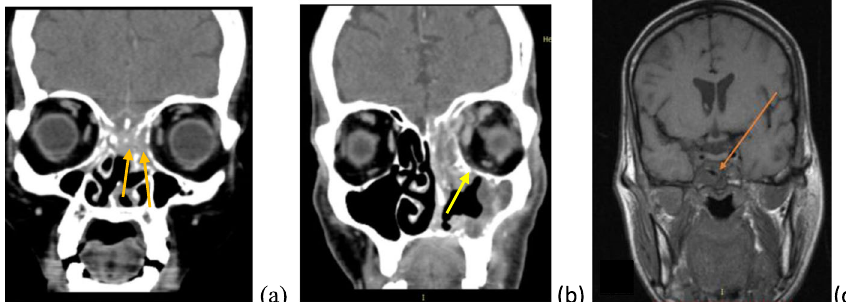
Fig. 7 a – c Radiological investigations of prototype cases of case series 4. a CT PNS shows hypodense opacities in bilateral ethmoids with erosion of cribriform plate bilaterally. b CT PNS of a patient with rhino orbital mucormycosis showing (L) intra orbital abscess with defect in cribriform plate. c MRI (T1 weighted) image of a patient with rhino orbital cerebral mucormycosis with cavernous sinus thrombosis